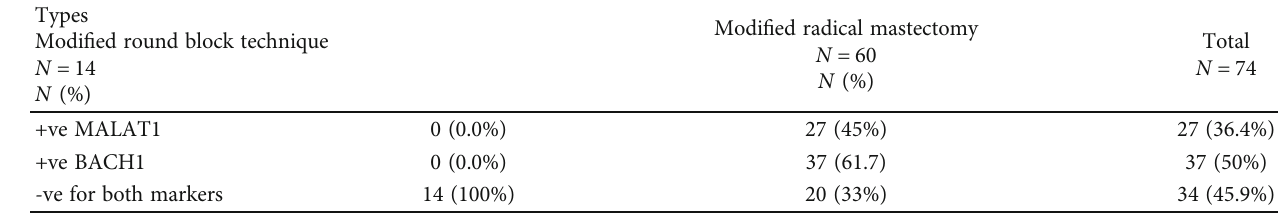
Table 10: Marker expression in both studied patients.